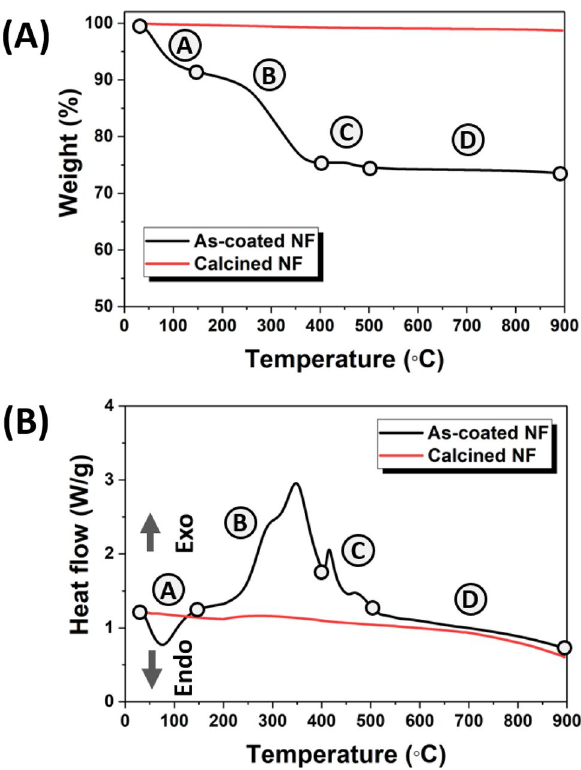
Figure 4. TGA–DSC measurement of as-coated (black line) and calcined (red line) 1.0 M TiO 2 -coated NF: ( A ) TGA and ( B )